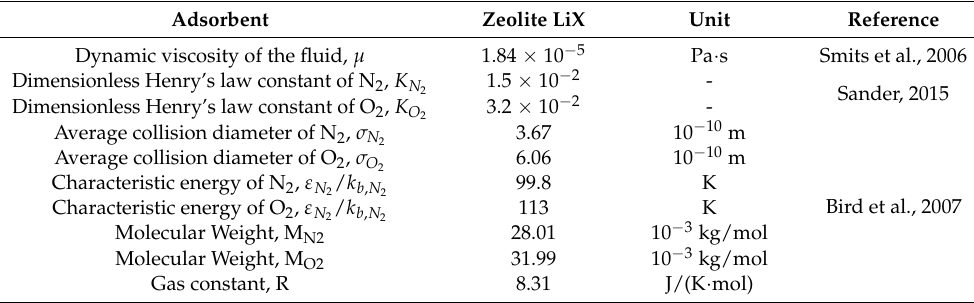
Table 4. Characteristics parameters of nitrogen and oxygen [38–40].